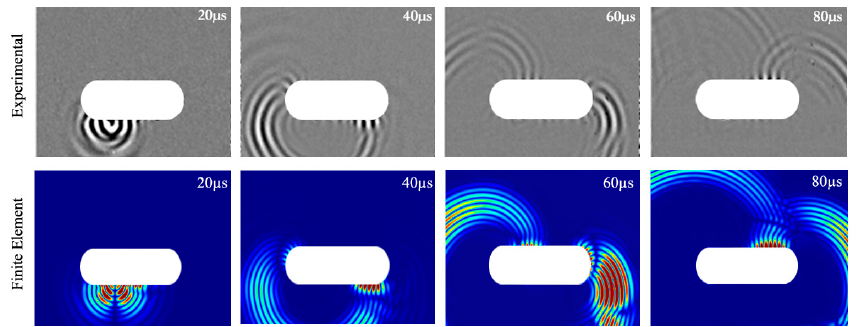
Figure 4. Time snapshot of the experimental wave field in the vertical component and computational total wave field of the edge-guided wave propagating around the racecourse shaped hole at 20, 40, 60 and 80 µs.